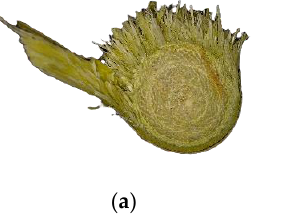
Figure 14. Sawing surface quality with different sawing speeds(( a ) 𝑉 𝑐 < 35 m/s; ( b ) 𝑉 𝑐 > 45 m/s).